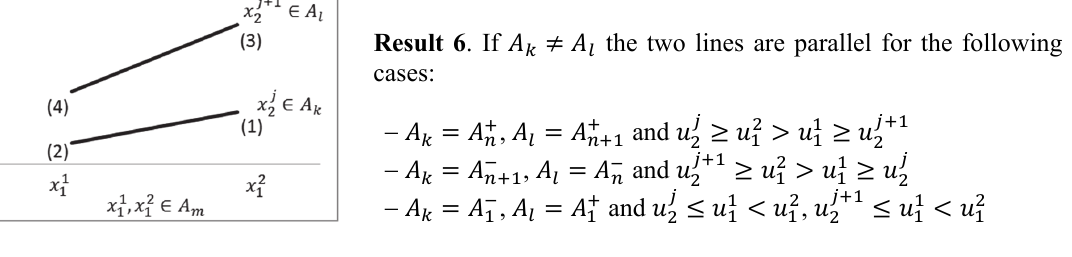
Result 5 . If 𝐴 conditions of unipolar capacity are valid. = 𝐴 (cid:3038) (cid:3039) Result 6 . If 𝐴 the two lines are parallel for the following ≠ 𝐴 (cid:3038) (cid:3039) cases:  𝐴 = 𝐴 (cid:3041)(cid:2878) , 𝐴 = 𝐴 (cid:3041)(cid:2878)(cid:2869)(cid:2878) and 𝑢 (cid:2870)(cid:3037) ≥ 𝑢 (cid:2869)(cid:2870) > 𝑢 (cid:2869)(cid:2869) ≥ 𝑢 (cid:2870)(cid:3037)(cid:2878)(cid:2869) (cid:3038) (cid:3039)  𝐴 = 𝐴 (cid:3041)(cid:2878)(cid:2869)(cid:2879) , 𝐴 = 𝐴 (cid:3041)(cid:2879) and 𝑢 (cid:2870)(cid:3037)(cid:2878)(cid:2869) ≥ 𝑢 (cid:2869)(cid:2870) > 𝑢 (cid:2869)(cid:2869) ≥ 𝑢 (cid:2870)(cid:3037) (cid:3038) (cid:3039)  𝐴 = 𝐴 (cid:2869)(cid:2879) , 𝐴 = 𝐴 (cid:2869)(cid:2878) and 𝑢 (cid:2870)(cid:3037) ≤ 𝑢 (cid:2869)(cid:2869) < 𝑢 (cid:2869)(cid:2870) , 𝑢 (cid:2870)(cid:3037)(cid:2878)(cid:2869) ≤ 𝑢 (cid:2869)(cid:2869) < 𝑢 (cid:2869)(cid:2870) (cid:3038) (cid:3039)